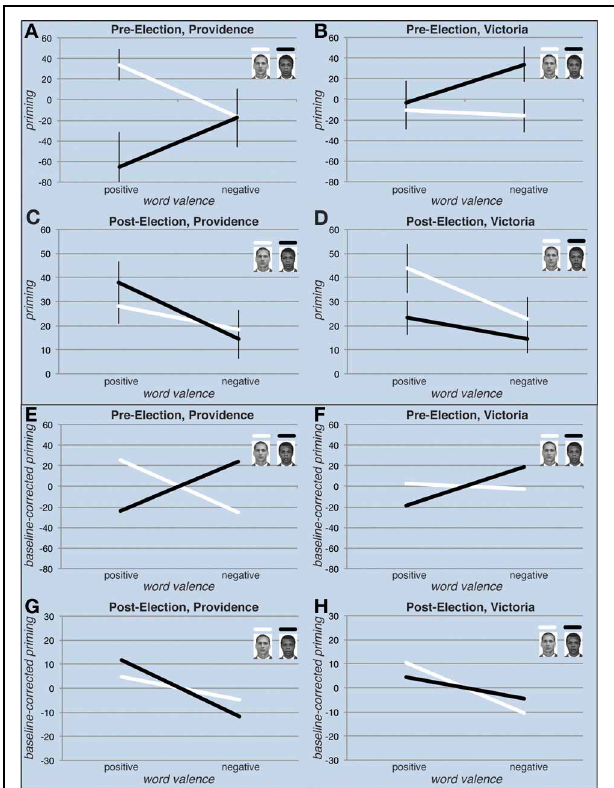
FIGURE 4 | Pre-election vs. post-election priming results. To more clearly illustrate the interactions of interest, raw priming effects with between-participant standard errors are shown in (A–D) , while baseline-corrected priming effects—in which the mean for each race face prime condition is subtracted from the raw priming data—are shown in (E–H) . Baseline-corrected data is shown without the between-participant standard errors in that the critical illustrative point for these panels is the within-participant interactions. Before the 2008 US presidential election participants in both the US and Canada showed a crossover interaction in which black and white faces differentially primed positive and negative words (A,B,E,F) . Consistent with the extant literature on implicit attitudes, white faces primed positive words more than negative words, while black faces primed positive words less than negative words. After the 2008 US presidential election participants in the US showed a reversal in their crossover interaction, with black faces also priming positive words more than negative words (C,G) . In contrast, participants in Canada showed a crossover interaction consistent with their pre-election results, albeit one in which, although not significant, black faces primed positive words slightly more than negative words (D,H)